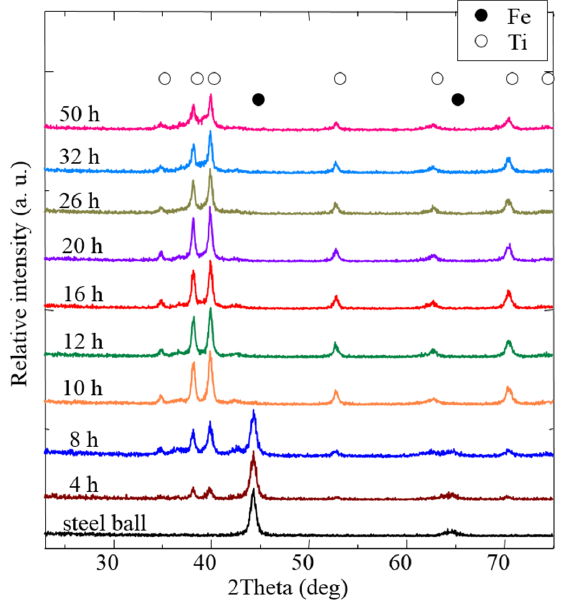
Figure 1. XRD patterns of the Ti coatings prepared by mechanical coating on steel balls at 300 rpm.